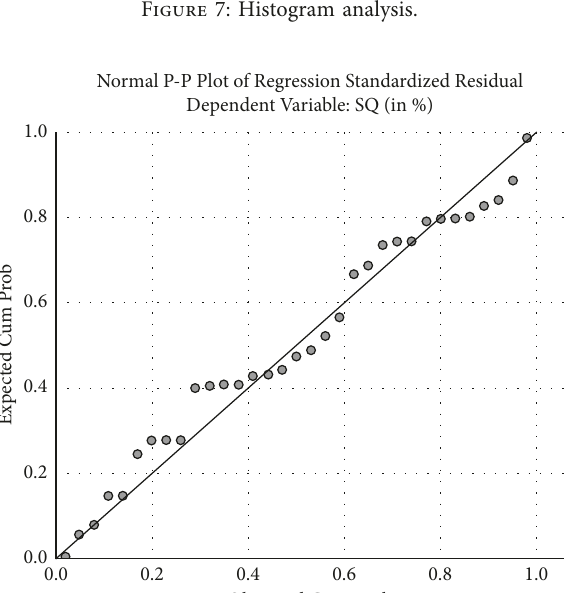
Figure 7: Histogram analysis.